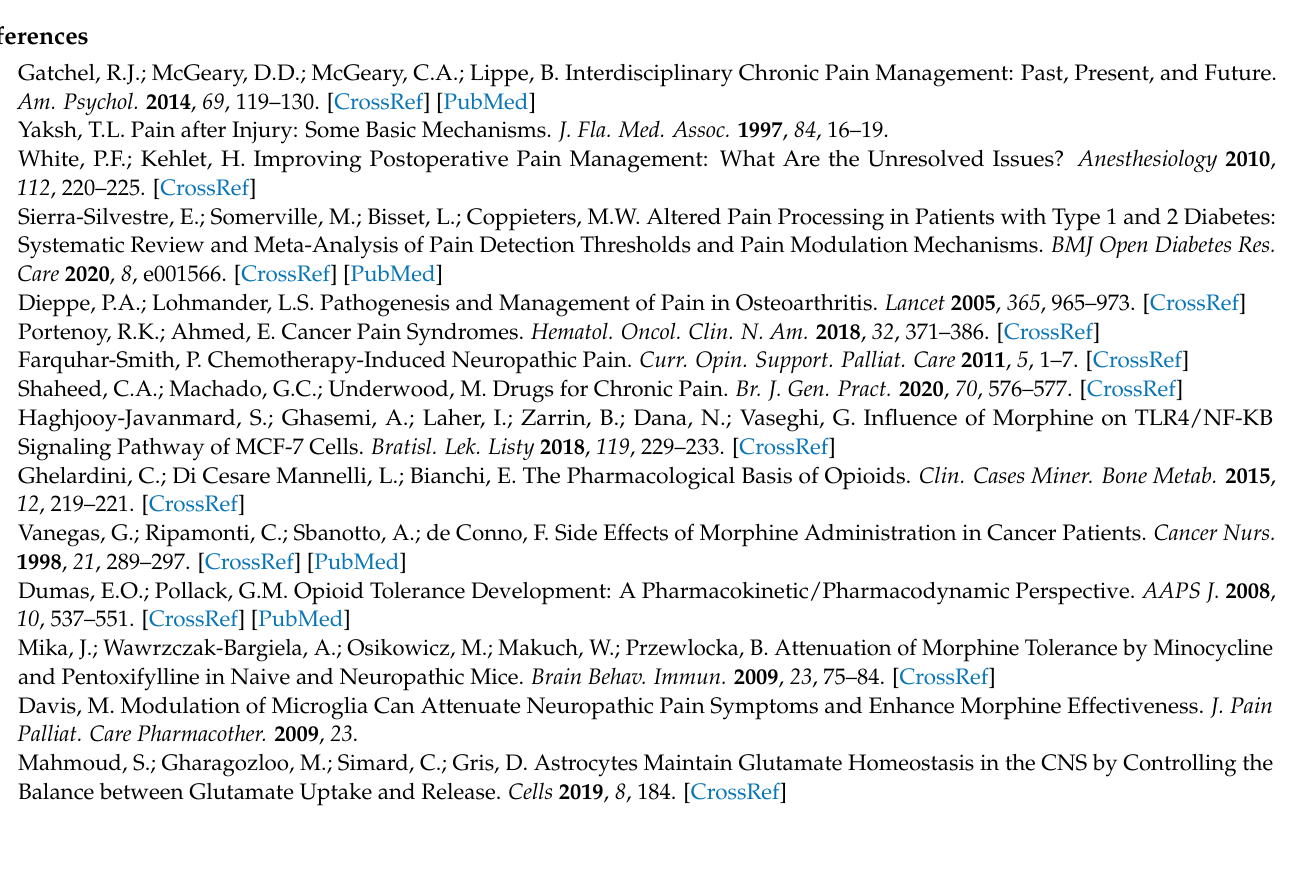
Figure S4. Effect of PEA 10 and 100 µ M on RBL-2H3 degranulation. Figure S5. Effect of